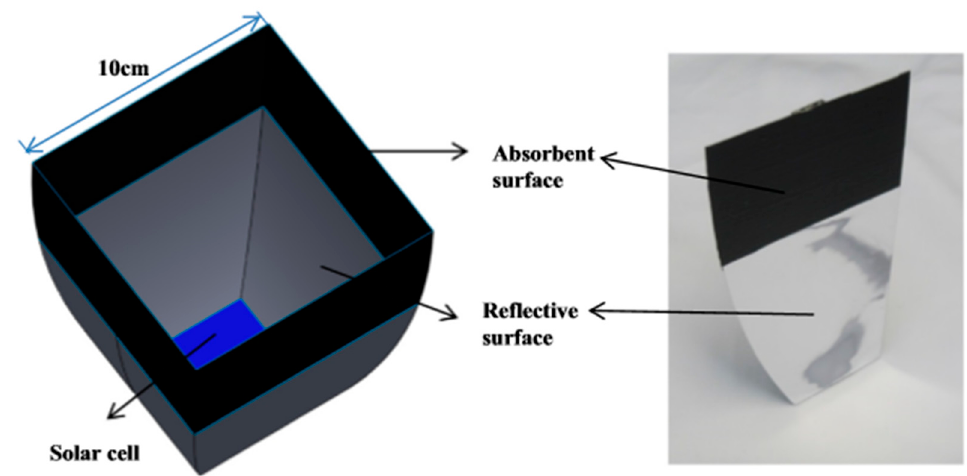
Figure 3. Geometrical structure of A/R CCPC for modelling and testing by Meng et al. Reproduced from [8], Elsevier, 2016.